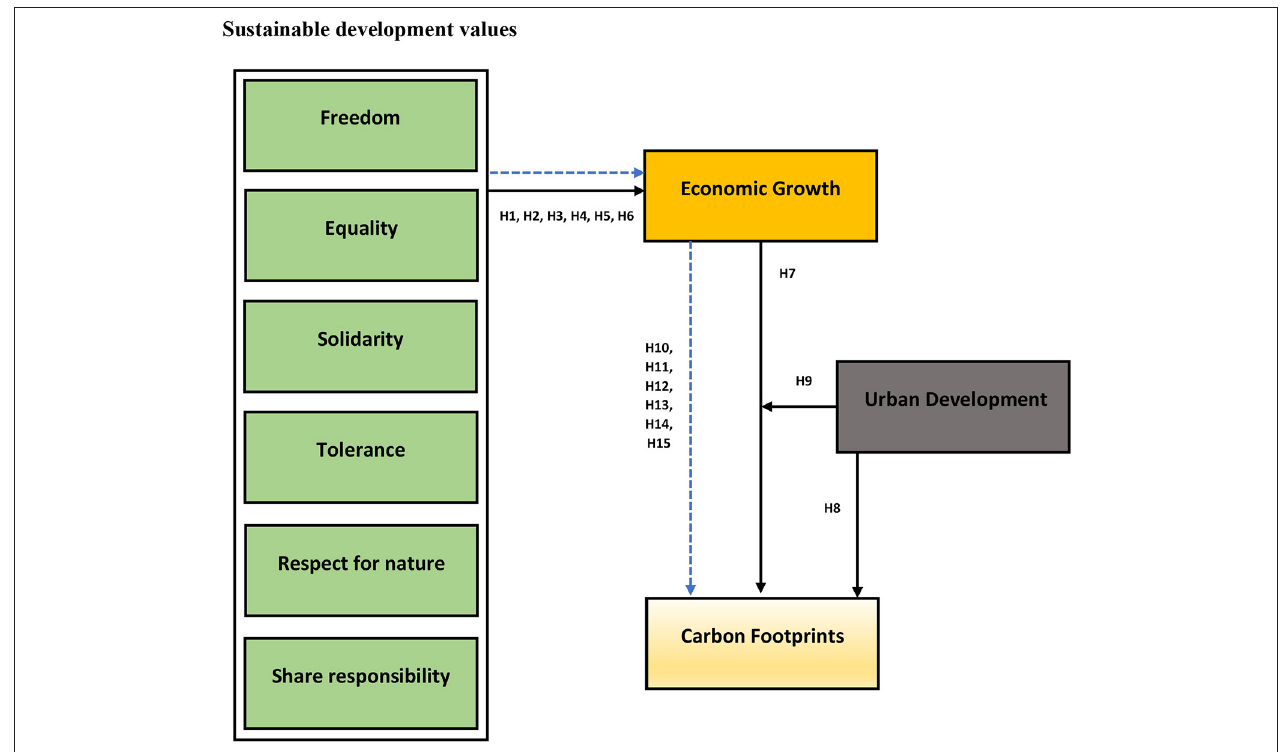
FIGURE 1 | Conceptual